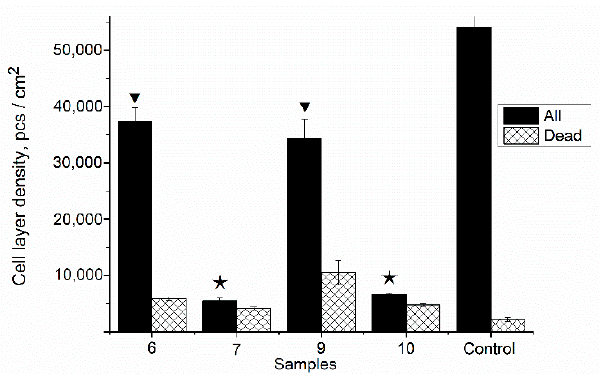
Figure 11. The number of DPSC mesenchymal stem cells cultured on the film surface. Sample 6— PVP-SA (1:1); sample 7—PVP-SA-HA (1:1, HA in situ); sample 9—PVP-SA (1:2); sample 10—PVP- SA-HA (1:2, HA in situ) (see Table 1). Control sample—glass slide. The triangles correspond to PVP-SA blends, the stars correspond to composites PVP-SA-HA in situ. The statistical analysis of